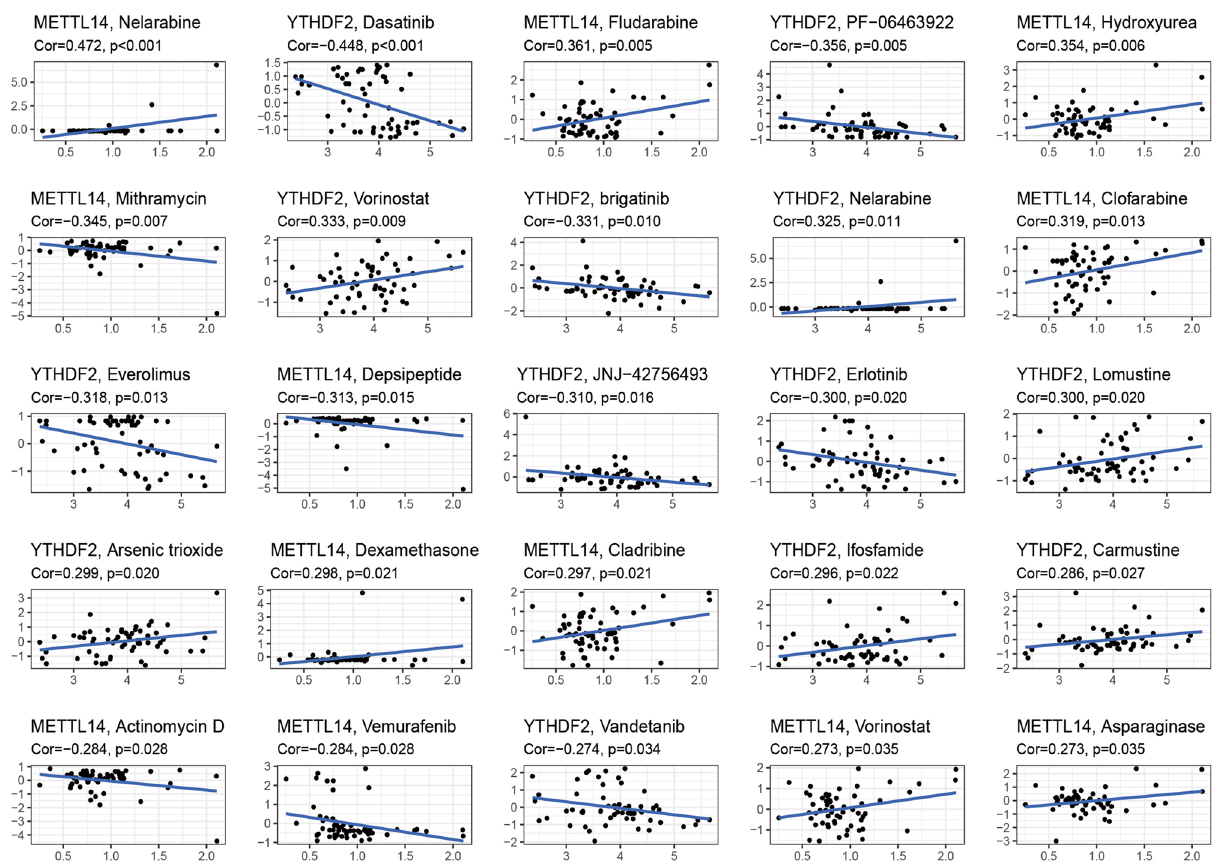
Figure 10. Drug sensitivity analysis. The figure shows the relationship between METTL14 and YTHDF2 each with different drug sensitivities. If Cor > 0, the high expression of this gene showed a positive correlation with drug sensitivity. If Cor < 0, the high expression of this gene showed a negative correlation with drug